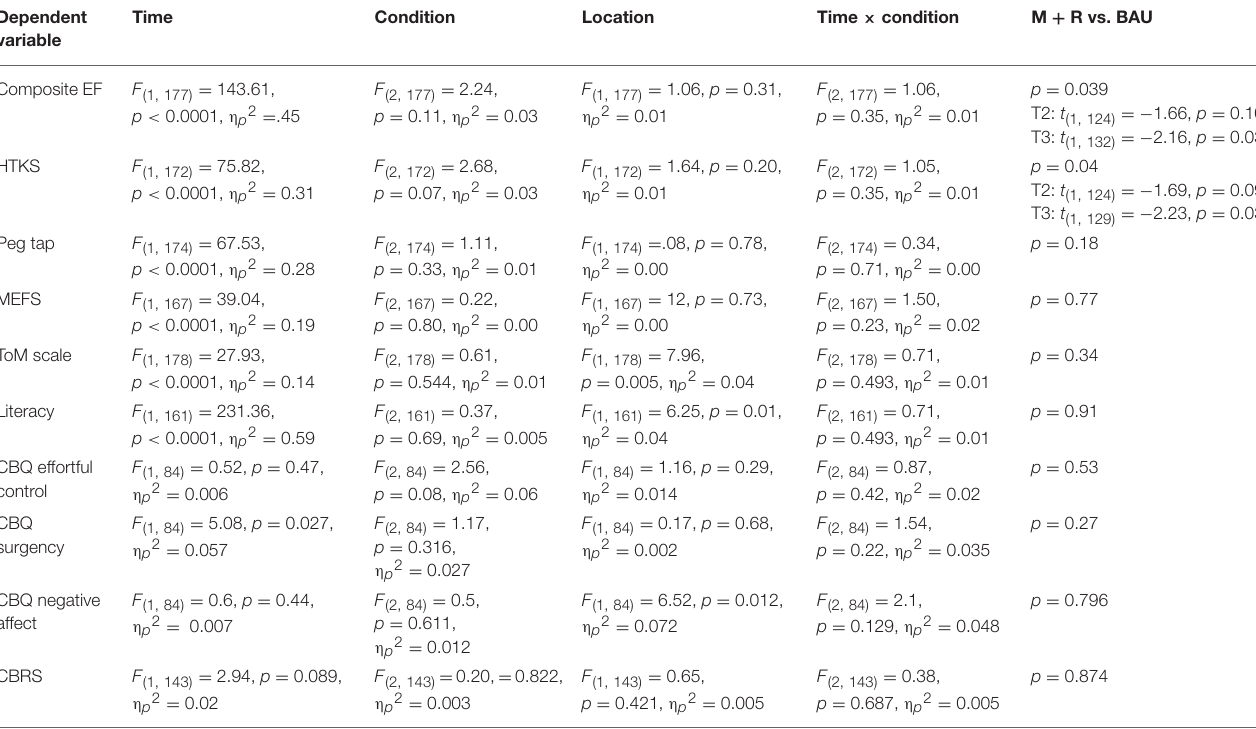
TABLE 5 | Results of the repeated measures mixed ANOVAs. Dependent variable